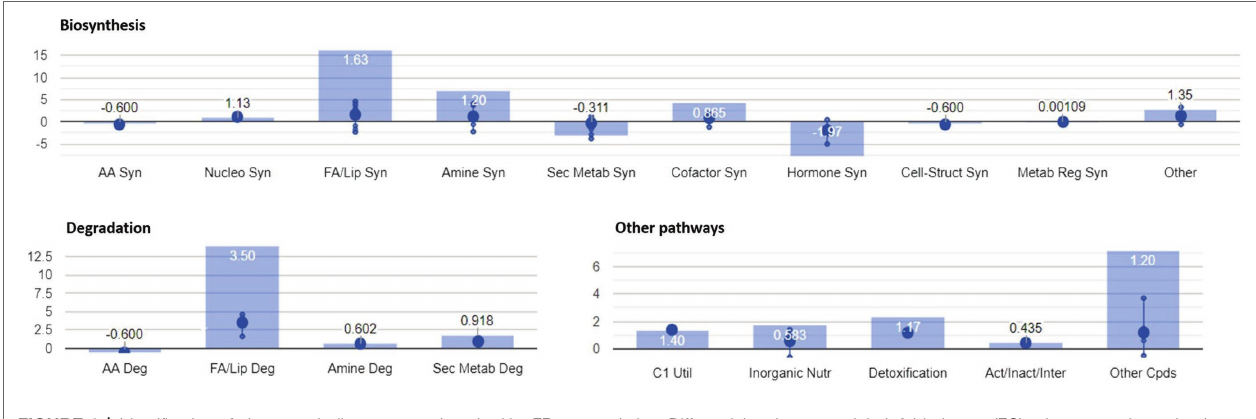
FIGURE 4 | Identification of plant metabolic processes impaired by FB accumulation. Differential pathways and their fold-change (FC) values were determined using the Omics Viewer Dashboard of the PlantCyc Pathway Tool software. Large dots represent the mean of all log 2 (FC) values of the pathways, and small dots represent the log 2 (FC) values of different biochemical classes of metabolites included in a specific pathway. The x -axis represents each set of subcategories, while the y -axis corresponds to the cumulative log 2 (FC). The value of p is reported in white at the top of each bar. Syn, biosynthesis; Deg, degradation; FA/Lip, fatty acids and lipids; Amines, amines and polyamines; Sec Metab, secondary metabolites synthesis; AA, amino acids; Nucleo, nucleotides; Cell-Struct, compounds responsible for cell structure; C1 util, consumption of carbon sources; Act/Inact/Inter, activation, inactivation, and interaction pathways; and Cpds,